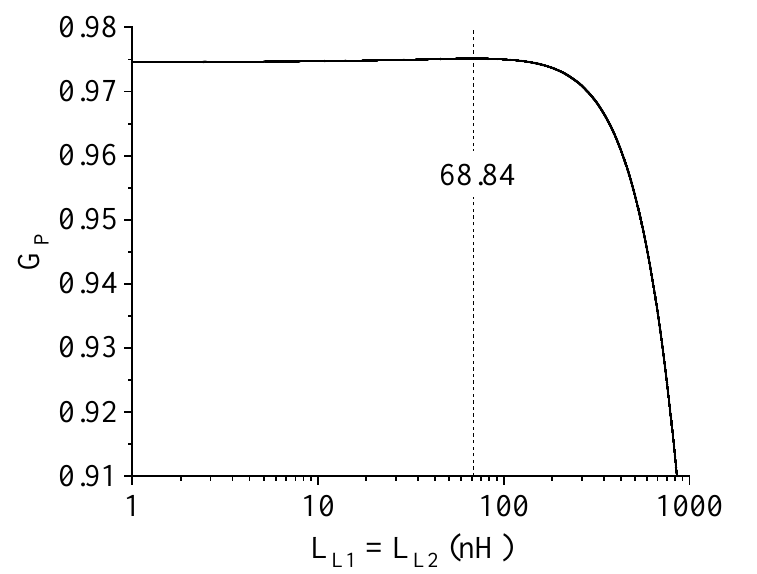
Figure 6. Case 1: efficiency calculated for Case 1 by varying the compensating inductor of the loads, i.e., L L1 = L L2 while all the other parameters are set to the optimal